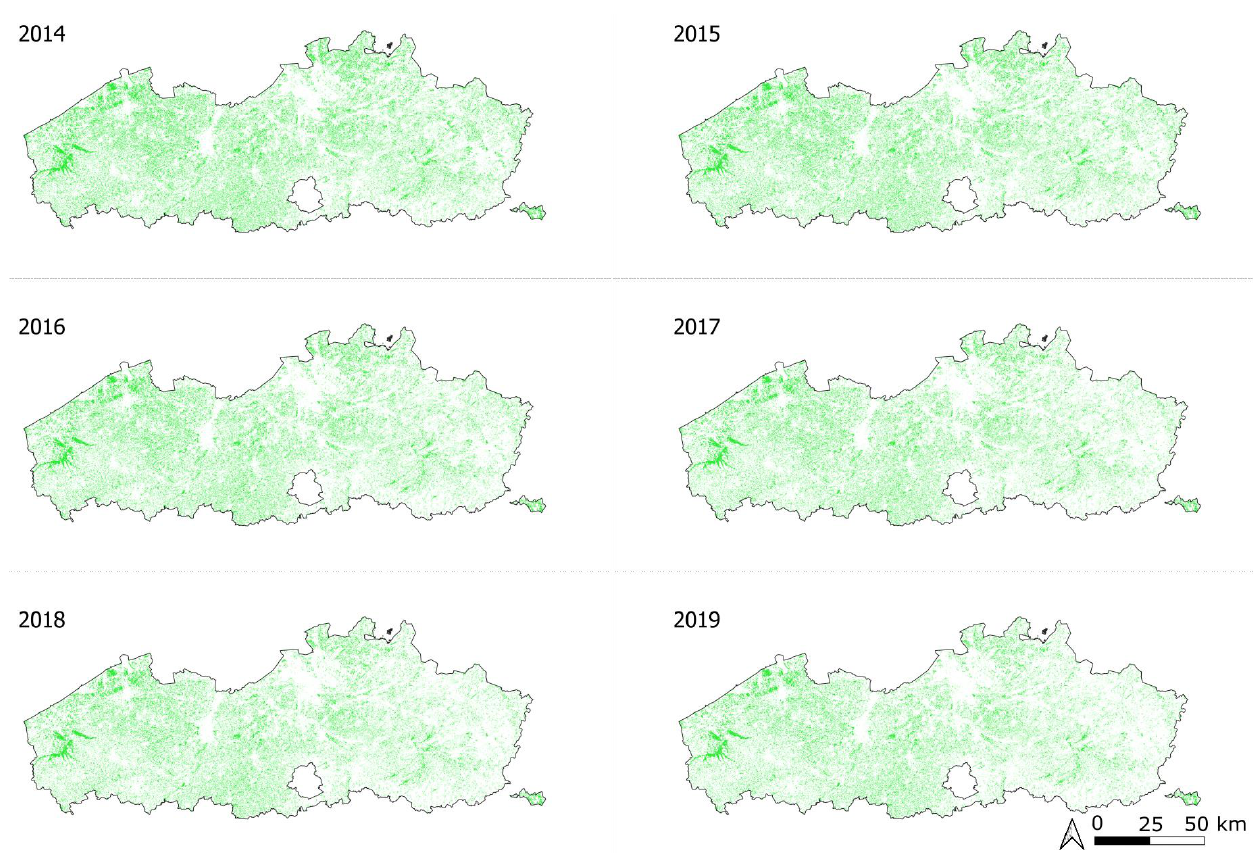
Figure 6. Map indicating the location of long-term grassland aged 10 years or more from 2014–2019.